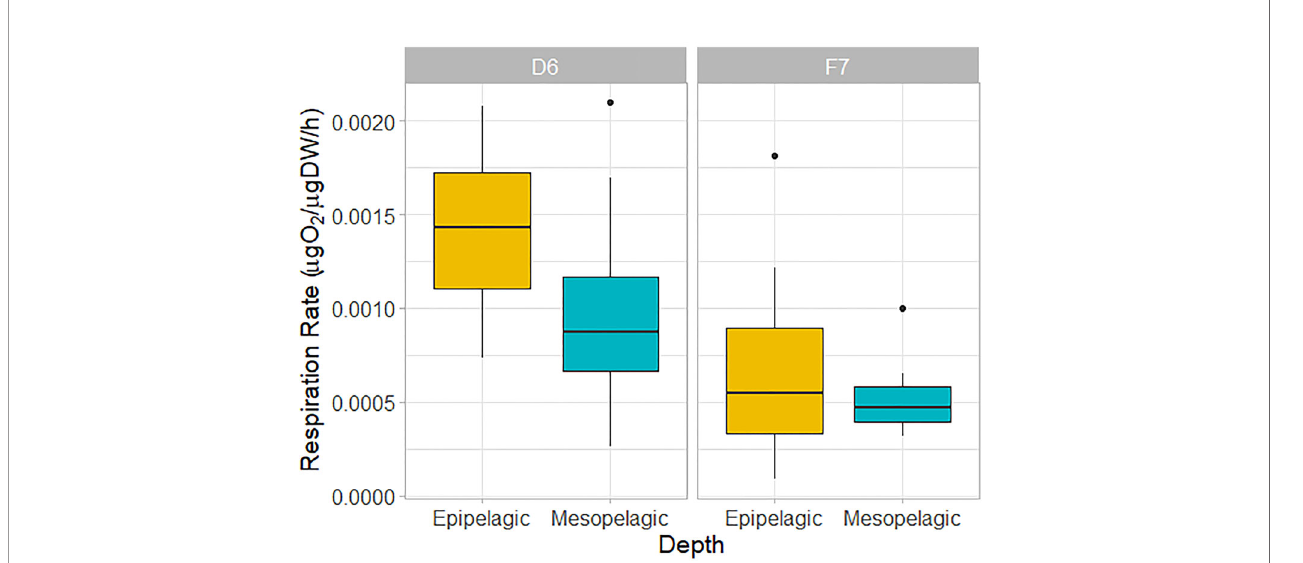
FIGURE 4 | Weight-speci fi c respiration rates of C. fi nmarchicus CV from epipelagic (yellow) and mesopelagic (blue-green) depths at slope station D6 and basin station F7. Box shows interquartile range around the median as the horizontal line, with black circles representing